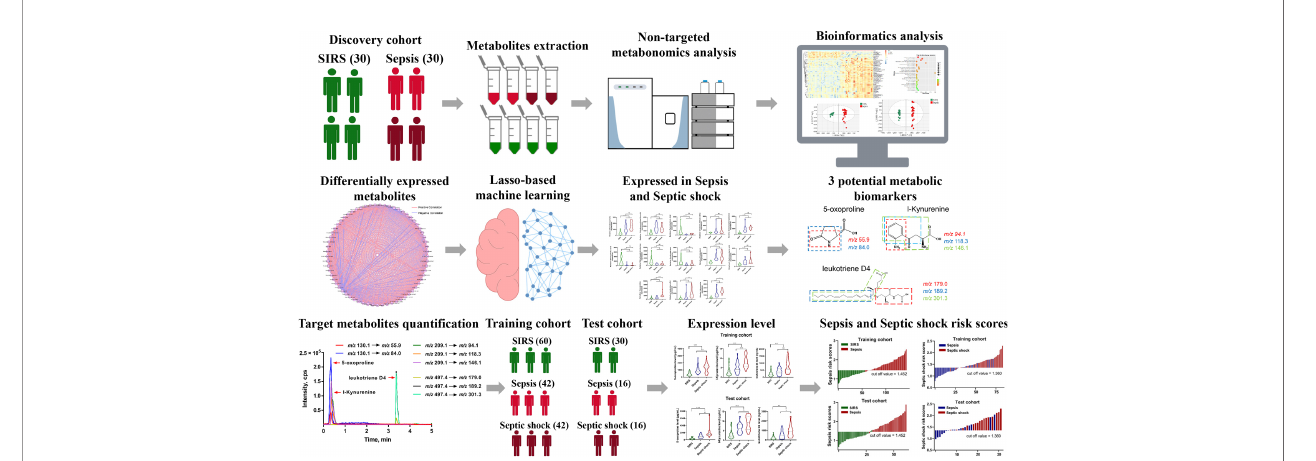
FIGURE 1 | Schematic work fl ow of Landscape of metabolic fi ngerprint for diagnosis and risk strati fi cation of sepsis. First, plasma samples from SIRS and sepsis participants were pro fi led using mass spectrometry-based untargeted metabolomics, and differentially expressed metabolites were identi fi ed. Then, least absolute shrinkage and selection operator regularization logistic regression based potential metabolic biomarkers selection was performed, and 3 potential metabolic biomarkers including 5-Oxoproline, L- Kynurenine and Leukotriene D4 were selected. Multiple reaction monitoring (MRM) based target metabolite quanti fi cation method was developed and the abundance of 5- Oxoproline, L-Kynurenine and Leukotriene D4 were determined in training and test cohort. Finally, respective risk scores for sepsis and septic shock based on 3-metabolite fi ngerprint classi fi er were established and diagnostic power was evaluated in clinical